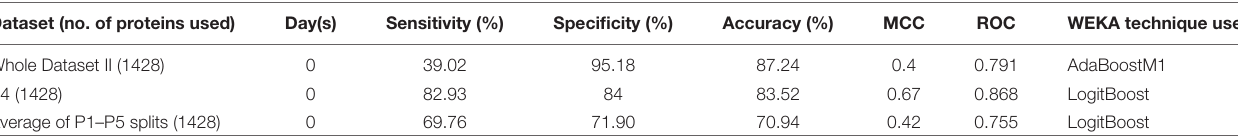
TABLE 3 | Performance of best models based on all 1428 proteins NPX values. Dataset (no. of proteins used) WEKA technique used